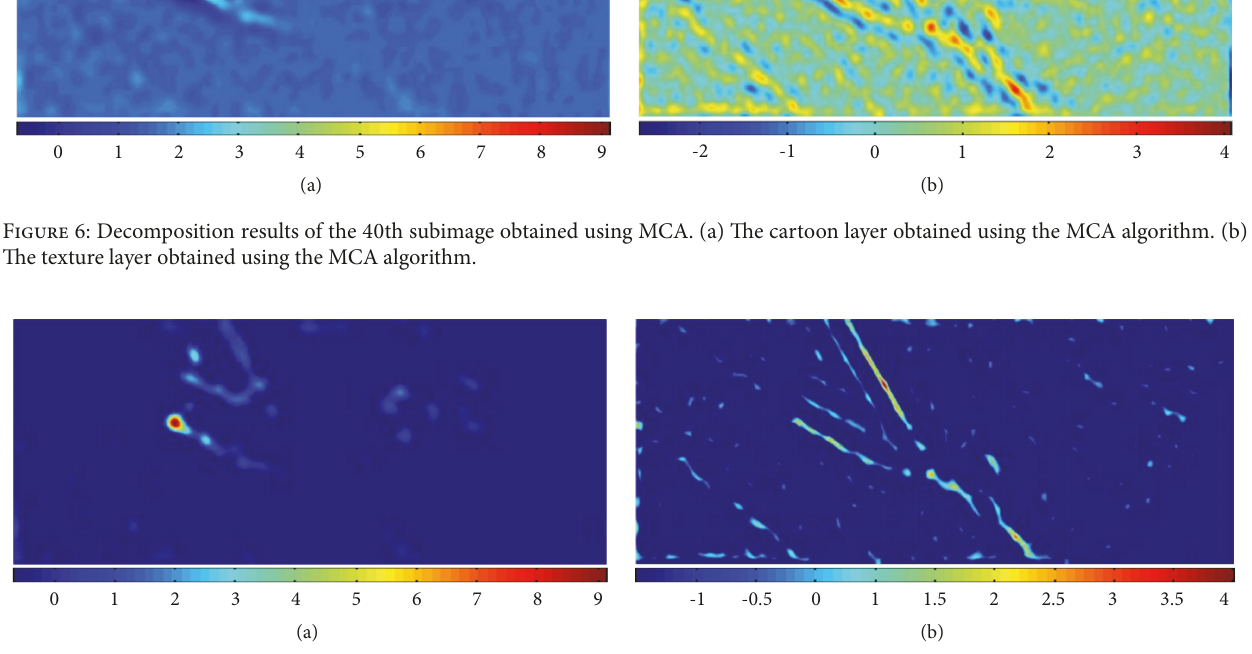
Figure 7: Denoising results for the cartoon layer and texture layer obtained using the iterative cleaning algorithm. (a) Denoising results for the cartoon layer of the 40th subimage. (b) Denoising results for the texture layer of the 40th